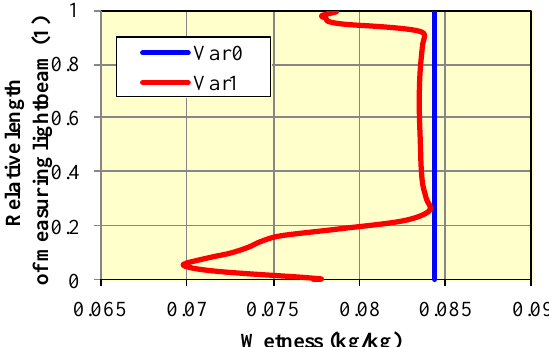
Fig. 11. Distribution of average steam wetness along the measuring beam for Var0 and